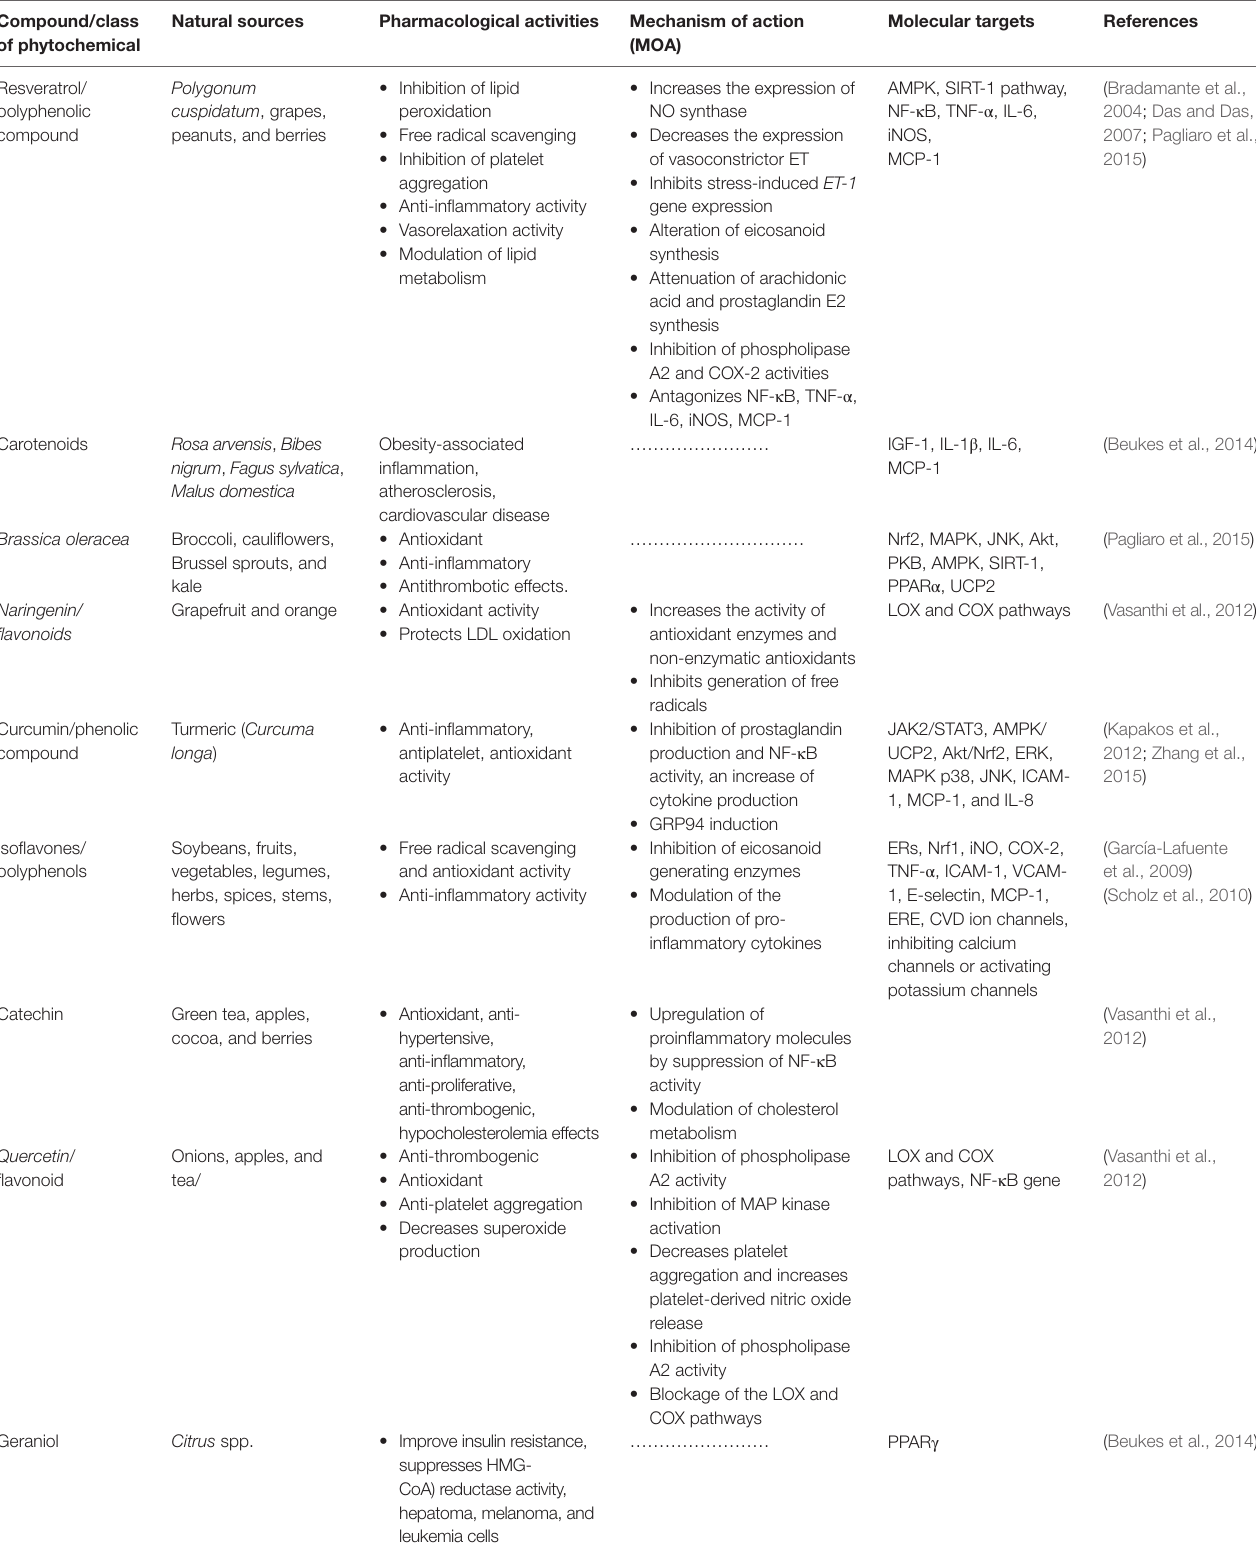
TABLE 1 | Plant-based CVD therapeutics, their pharmacological activities, mode of actions, and molecular targets. Compound/class of